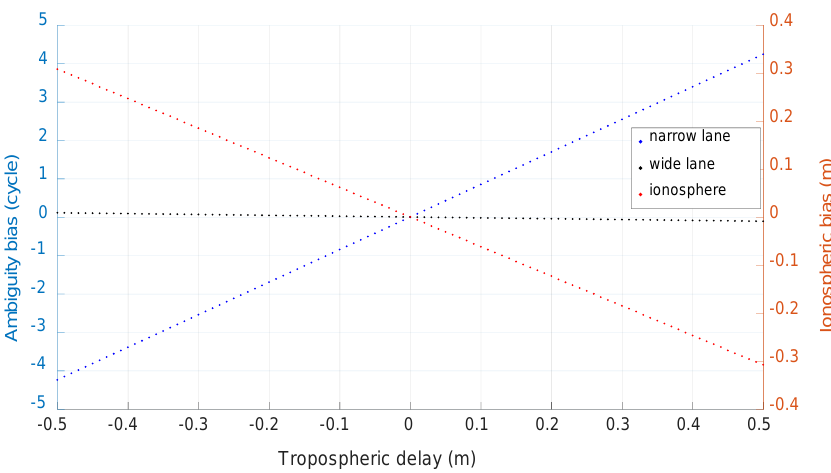
Figure 3. The caused bias of neglected tropospheric error (BDS).